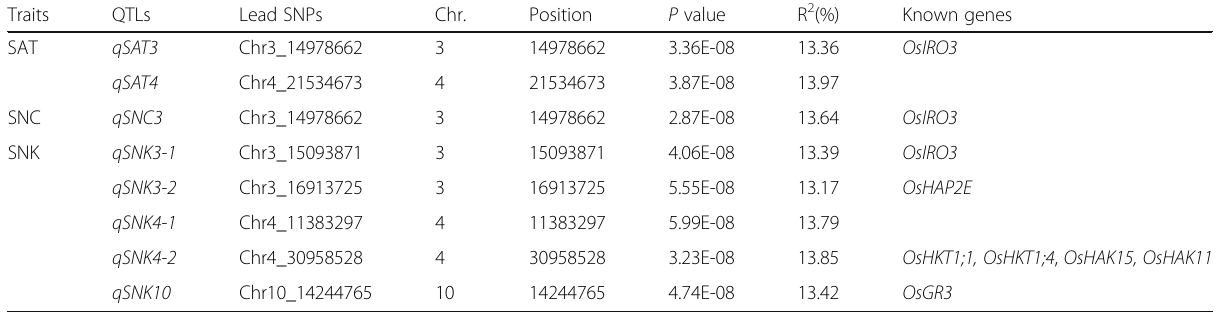
Table 2 The mapped QTLs associated with alkalinity tolerance of japonica rice at seedling stage Traits QTLs Lead SNPs Chr.